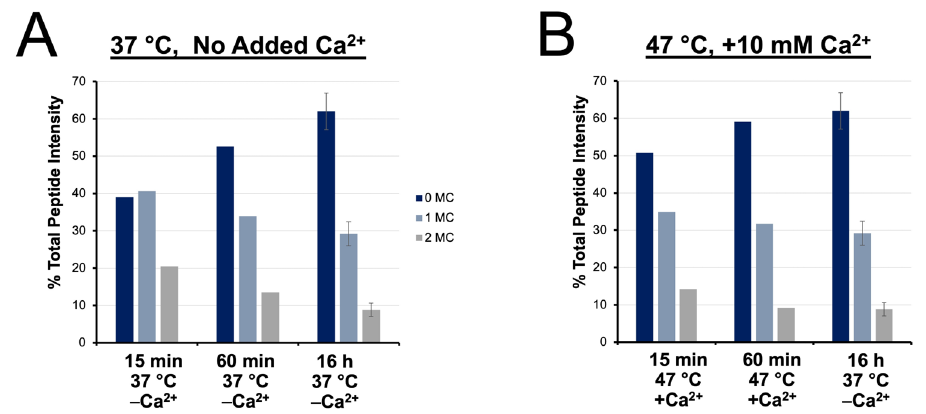
Figure 6. Relative quantitation of fully cleaved, singly miscleaved, and doubly miscleaved peptides. Time course of digestion completion, inferred by % total peptide intensity contributed by fully cleaved, singly and doubly miscleaved peptides at ( A ) 37 ◦ C with no added Ca 2+ and ( B ) 47 ◦ C with cleaved, singly and doubly miscleaved peptides at ( A ) 37 °C with no added Ca 2+ and ( B ) 47 °C with 10 mM added Ca 2+ compared to a conventional overnight digest. 10 mM added Ca 2+ compared to a conventional overnight digest.